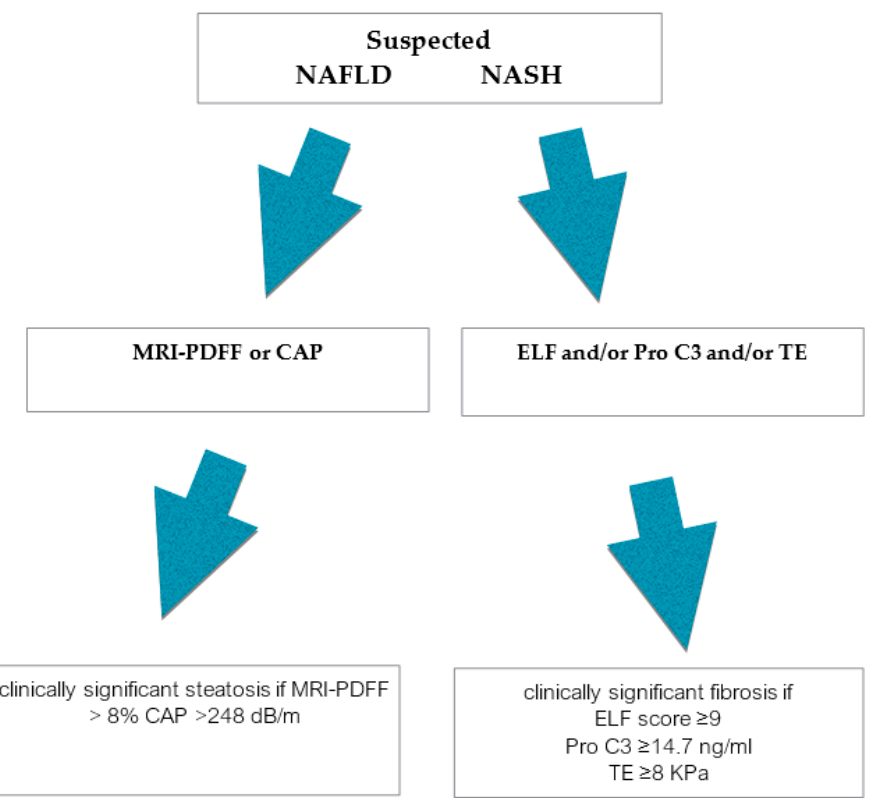
Figure 1. Proposed diagnostic algorithm based on a selection of currently available non- or minimally invasive markers of NAFLD and NASH.